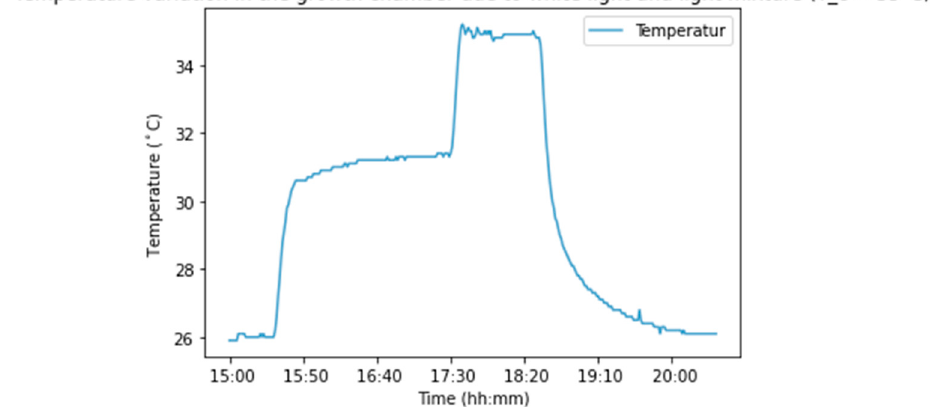
Figure 13. The temperature in a Growbot experiment when white light is turned on at 15:30, white, blue, and red light turned on at 17:30, and all lights turned off at 18:30.